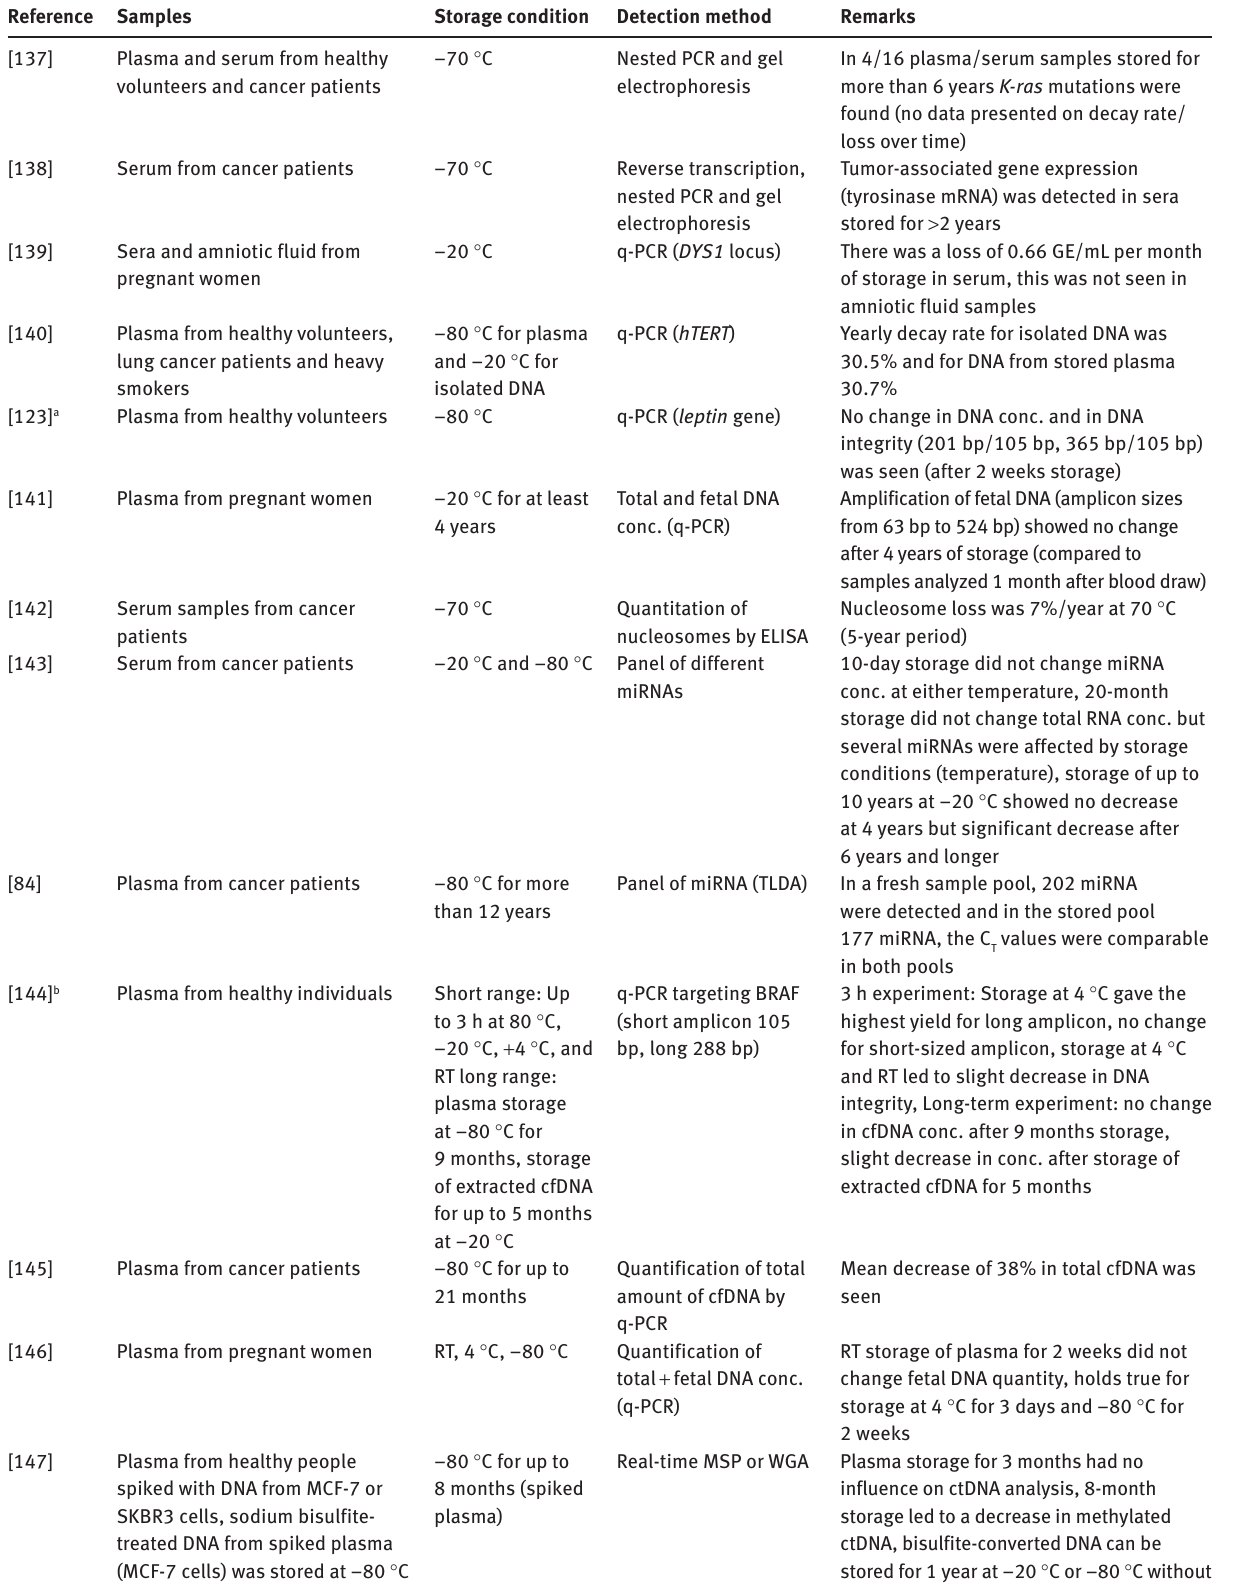
Table 6: Effects of long-term storage of cell-free matrix on cfDNA. Reference